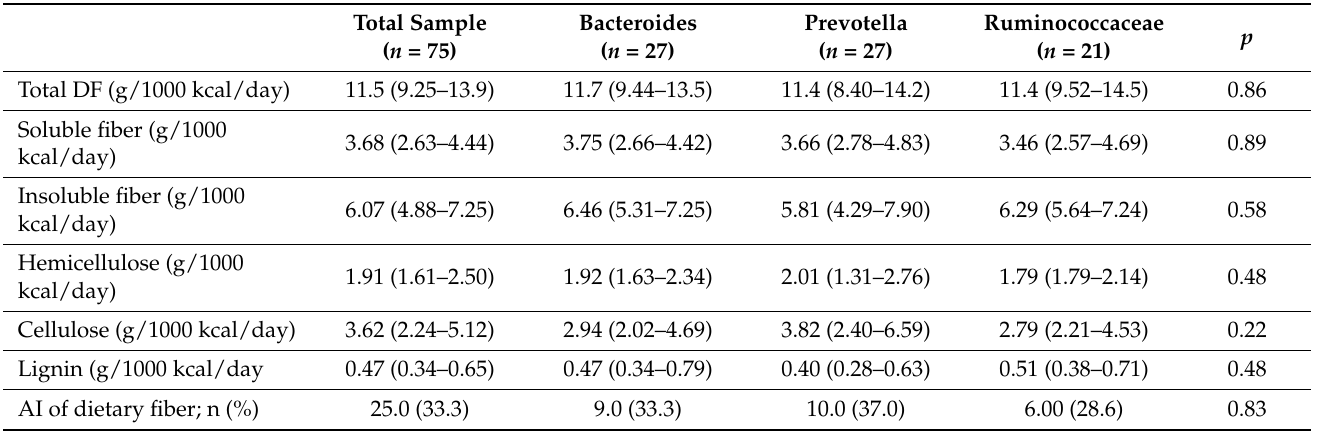
Values represent median and interquartile range or n and percentage. Significant p -values are shown in bold. BP: Blood pressure; AST: Aspartate aminotransferase; ALT: Alanine aminotransferase; GGT: Gamma glutamyl transferase; DF: Dietary fiber, AI: Adequate intake. Different superscript letters indicate statistically significant differences between groups after Dunn’s post hoc